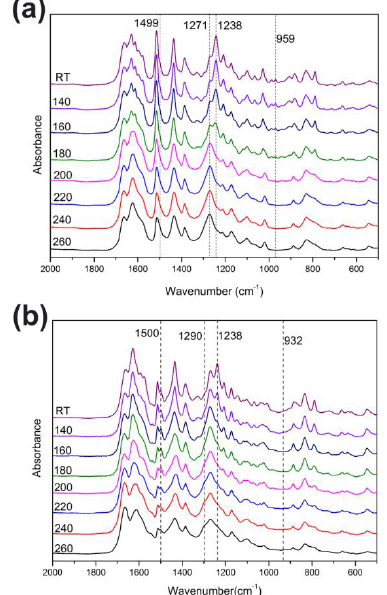
Figure 3. FT-IR spectra of poly(Dd-ddm) main ( a ) and poly(Dd-hda) main ( b ) obtained after various thermal treatments.